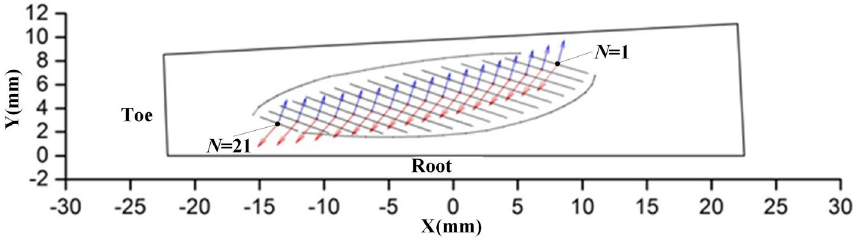
Figure 3. The lubricant entraining velocity and the minor axis of the contact ellipse of the different meshing positions of the e According to the contact parameters of Table 4, the lubricant entraining velocity v and the minor axis of the contact ellipse are obtained, as shown in Fig. 3. (The blue arrows are the direction of the minor axis of the ellipse, and red arrows are the direction of the entrainment velocity vector, respectively.) e The changes of the contact load F , entraining velocity v and angle θ are shown in Fig. 4. The driven gear tooth surface enters the mesh from the tooth tip near the large end side, and is engaged from the tooth root near the small end side. Compare the different engagement positions, the entraining velocity at addendum (enter mesh) is maximal, and the entrainment at the root position (out mesh) is minimal. As the meshing position moves from the addendum to the root, the angle between the lubricant entraining velocity and the minor axis of the contact ellipse becomes small.